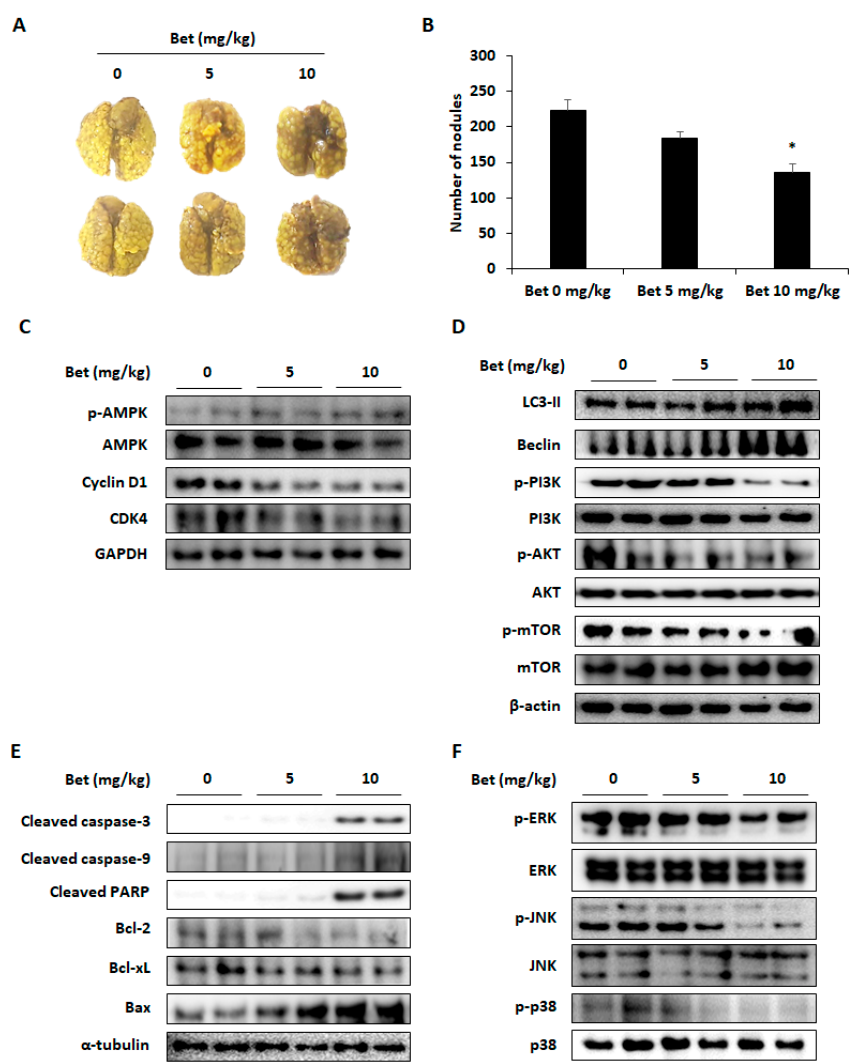
Figure 7. Betulin decreases lung metastasis of CT26 cells through cell cycle arrest, autophagy, and apoptosis by regulating AMPK, PI3K / Akt / mTOR, and MAPK signaling pathways. ( A ) Lung metastasis of CT26 cells was photographed at 14 days after inoculation. Images represent three independent experiments. ( B ) Number of nodules. ( C ) AMPK phosphorylation and expression of cyclin D1 and CDK4. ( D ) The level of autophagy-associated proteins. ( E ) Expression of apoptosis-related proteins in lung tissues as measured by western blot analysis. ( F ) The expression levels of p-ERK, p-JNK, and p-p38. Data are means ± standard deviation of three independent experiments. * p < 0.05.